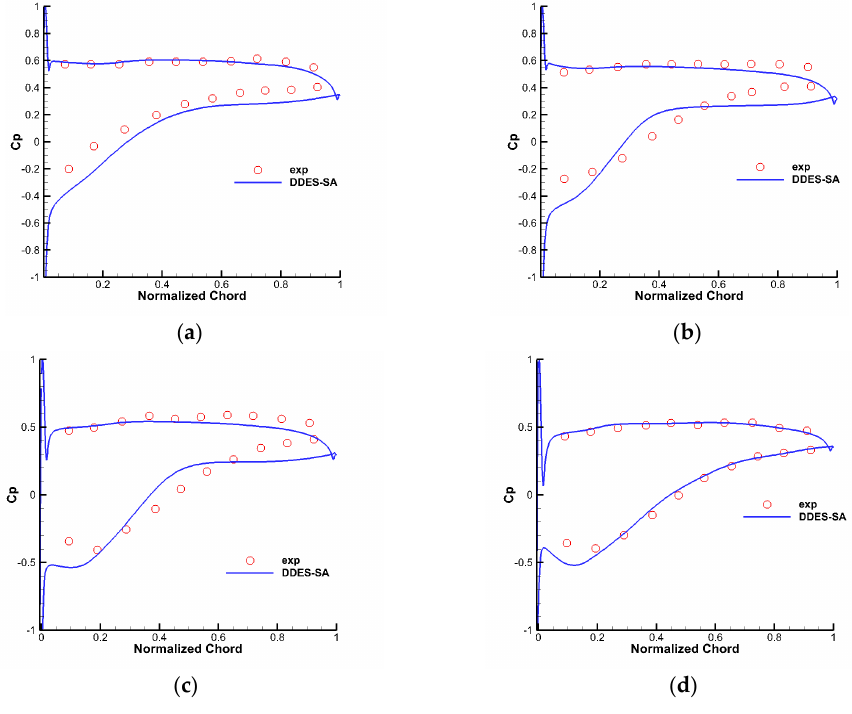
Figure 6. Time-averaged static pressure coefficient ( C p ) at different spans: ( a ) 10% span; ( b ) 30% span; ( c ) 50% span; ( d ) 70% span.